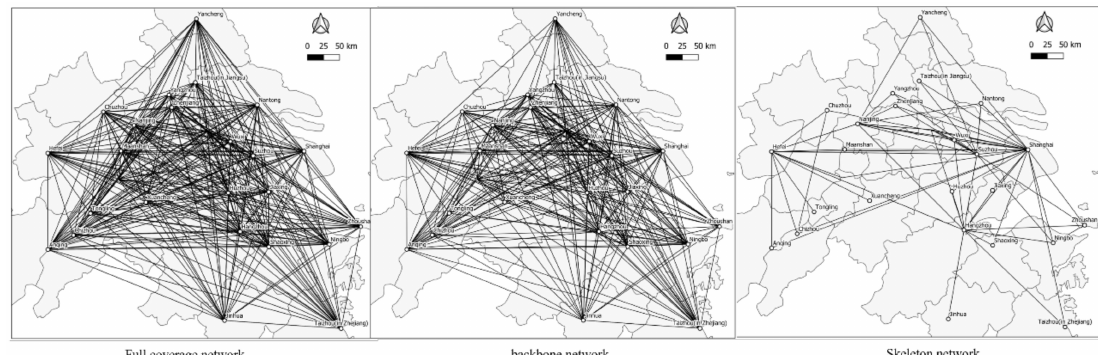
Figure 5. Information-flow network in 2015.